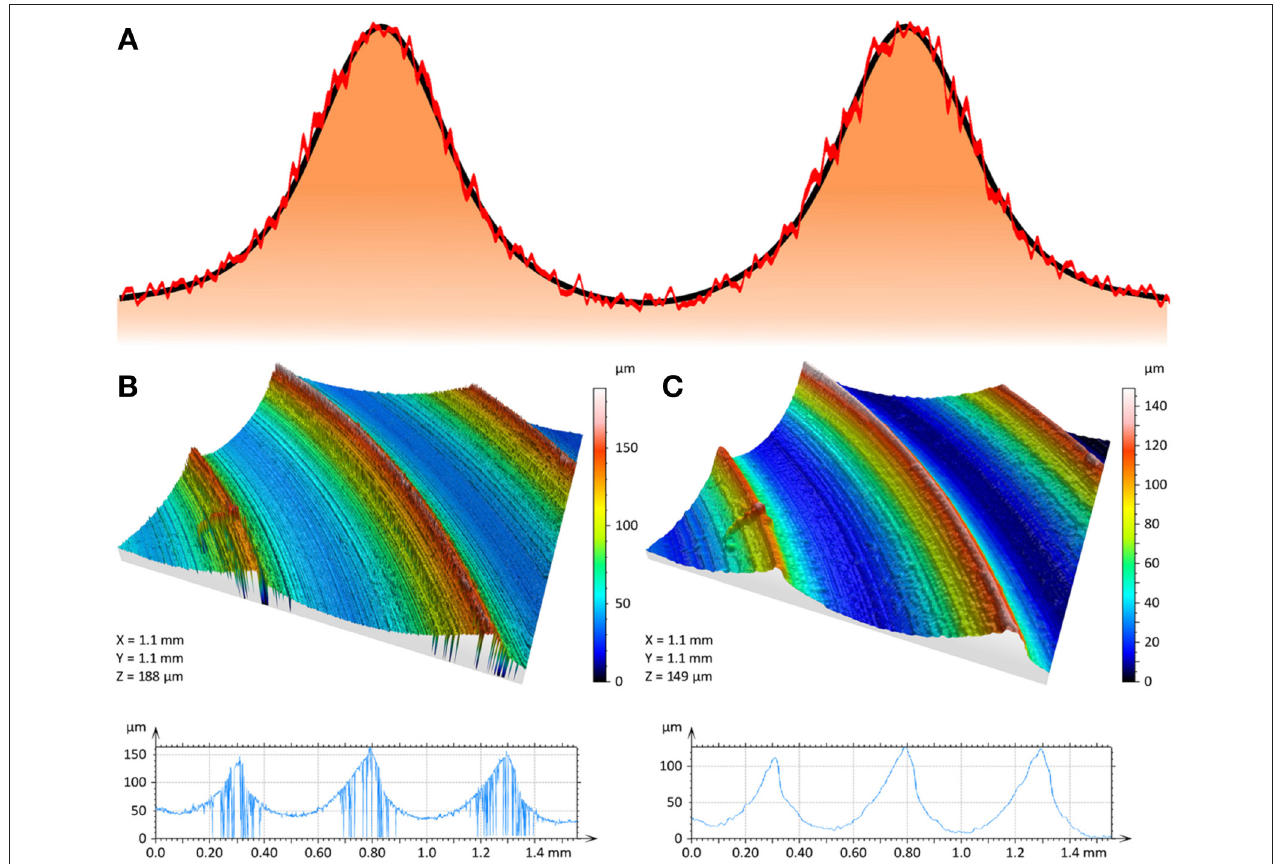
FIGURE 1 | (A) Schematic view of the Copper surface profile generated through the turning process. The black and red borders represent, respectively, the waviness and roughness features of the surface. 3D-Images (top) and 2D-Profiles of the electrode surfaces (bottom); (B) unfiltered surface with measurement errors and (C) surface after application of a morphological